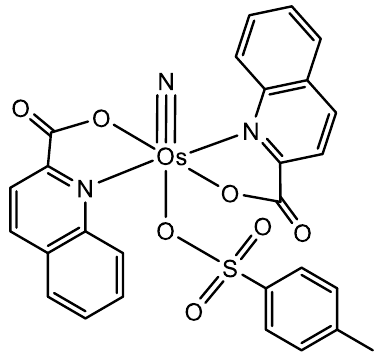
Figure 5. Structure of the osmium(VI) nitride complex. Adapted from [25]. Lindhorst et al. reported, in 2017 [26], a molecular iron-NHC complex (Figure 6) ca-